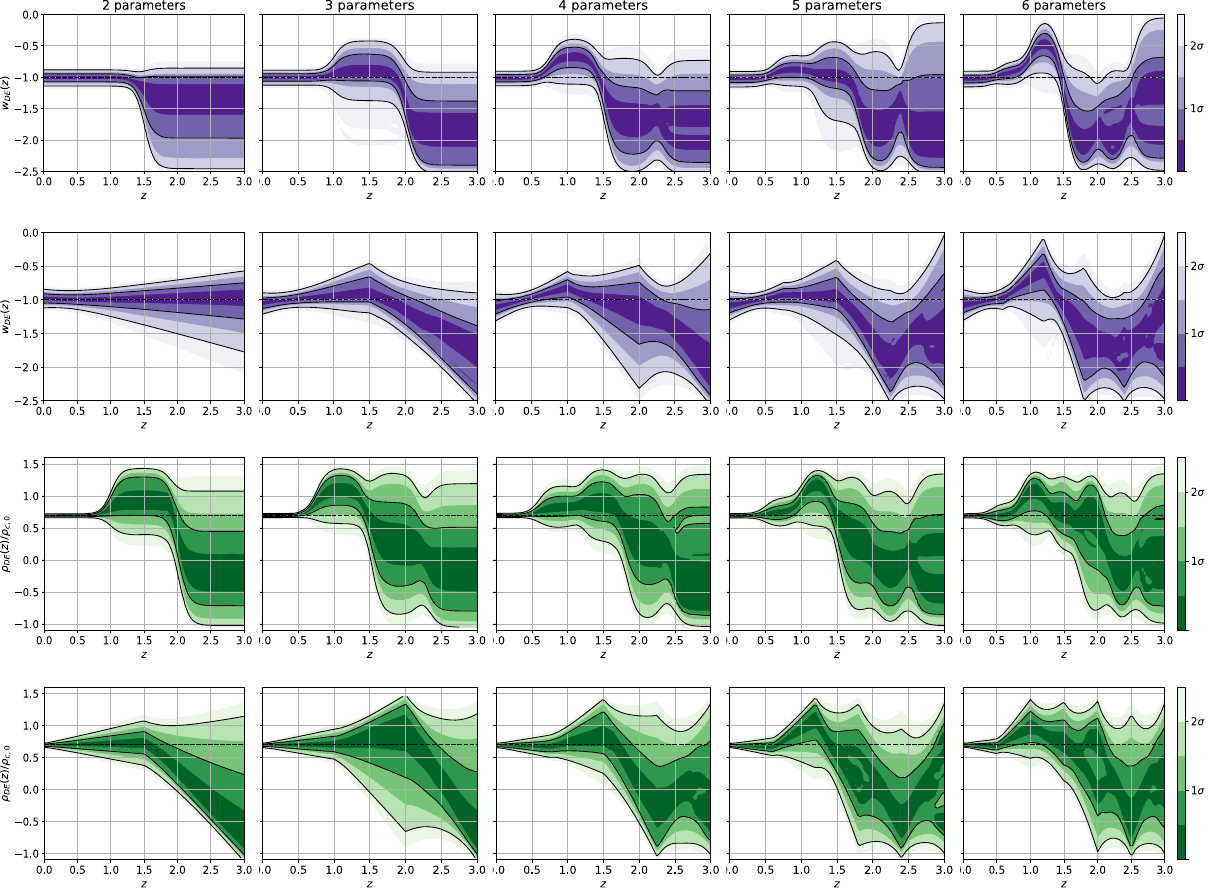
Fig. 4 From top to bottom: reconstructed w DE ( z ) with bins (and nodes), reconstructed ρ DE ( z )/ρ c , 0 with bins (and nodes). It is easy to observe there is more structure (more apparent features) in the reconstructions as the number of parameters increases (from left to